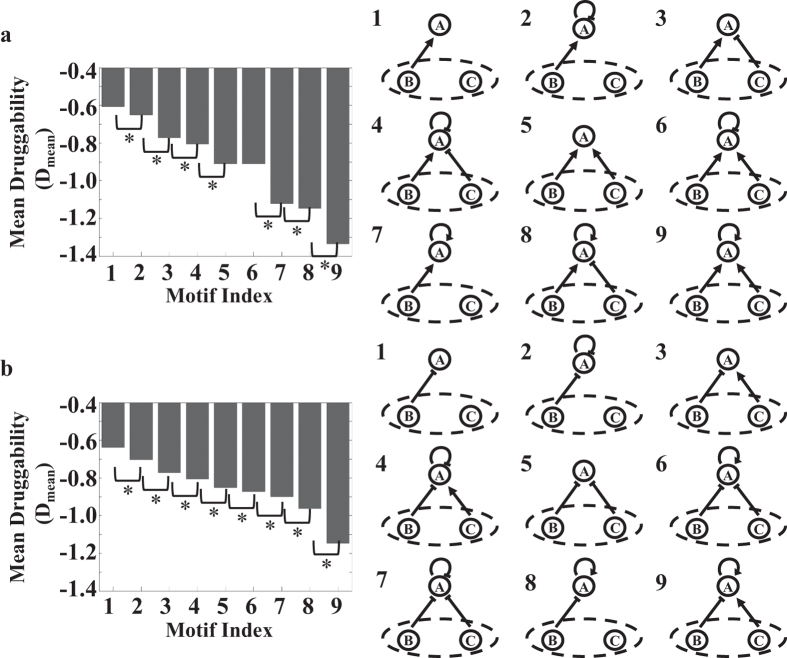
Effect of direct regulations on druggability.When detailed network motifs of a target are unknown, addition of a positive self-feedback loop to a drug target reduces druggability more than other regulations, unless it is counteracted by multiple negative direct regulations. Furthermore, addition of a direct regulation from buffer nodes with the same sign (positive indicates activation; negative indicates inhibition) as the pre-existing regulation reduces druggability more than the addition of a direct regulation from buffer nodes with the opposite sign. (a) Mean druggability (Dmean) of representative motifs (consist of at least one positive direct regulation from buffer nodes). The motifs are grouped based on only the direct regulations to node A. (b) Mean druggability (Dmean) of representative motifs (consist of at least one negative direct regulation from buffer nodes). The corresponding motifs are shown on the right of the bar graph. Asterisks indicate significant difference (N > 300,000, p-value < 0.05).